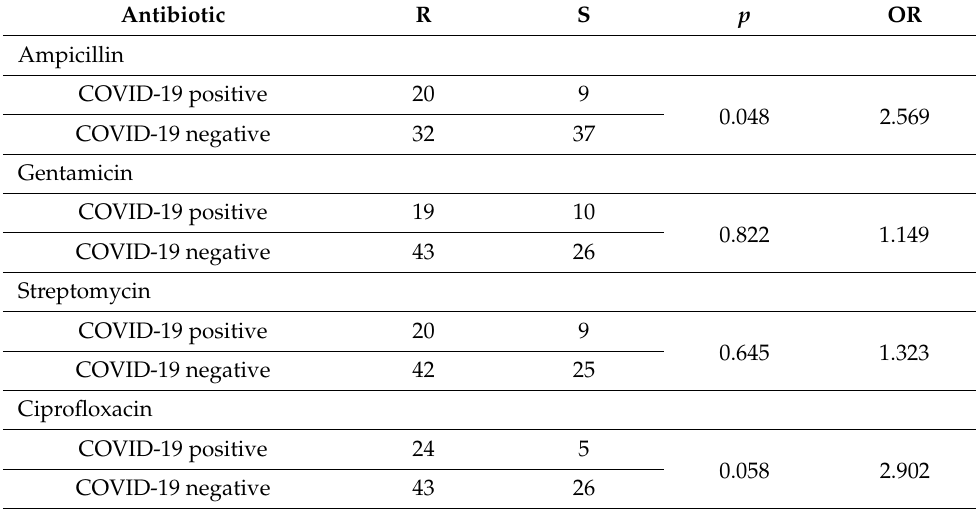
Table 10. Statistical analysis of antibiotic resistant strains among COVID-19